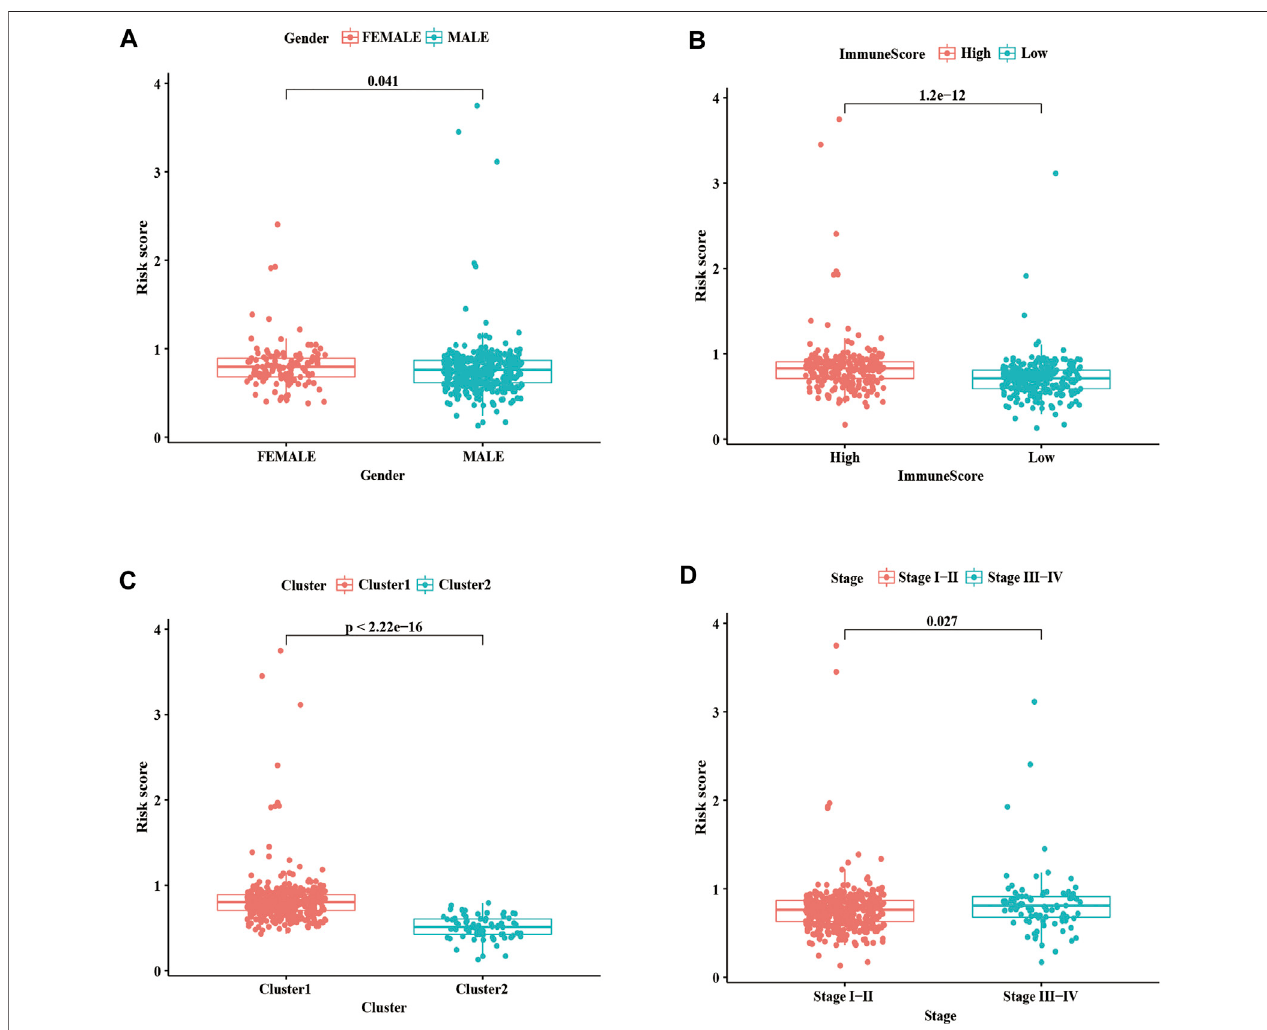
FIGURE 8 | Correlation analysis of risk score with clinicopathological characteristics and immune scores. (A) Boxplots of risk score with different genders. (B) Boxplots of risk scores and different immune scores. (C) Boxplots of risk scores and different clusters. (D) Boxplots of risk scores and different Stages. Statistical methods: Chi-square test. *** p <